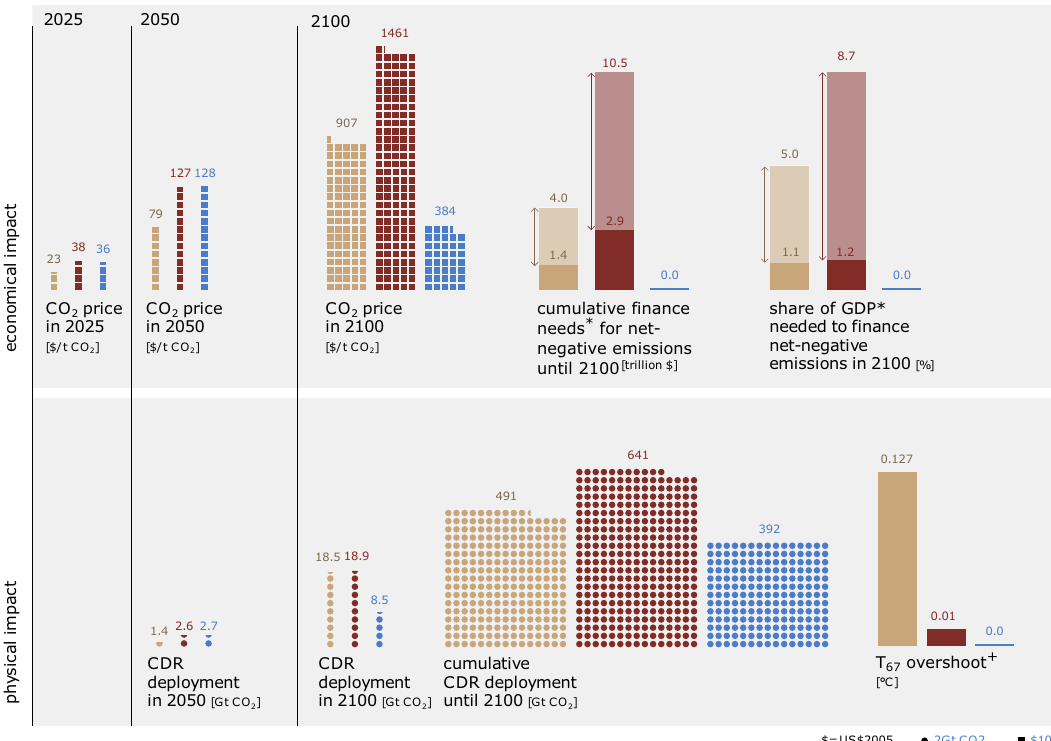
Fig. 2 Risk pro fi le of Hotelling Overshoot (light brown), Hotelling Below (dark brown), and Optimal (blue) scenarios. The upper panel shows the economic impact indicators CO 2 price (in 2025, 2050, and 2100), fi nance needs for net-negative emissions in absolute values and as share of GDP. The lower panel shows physical impact indicators Carbon Dioxide Removal (CDR) deployment (in 2050 and 2100), cumulative CDR deployment, and temperature overshoot. The Optimal scenario reduces long-term economic and physical risks and has near- and medium-term risks comparable to the Hotelling Below scenario. *These fi nance needs for net-negative emissions show upper estimates for the case that CDR is rewarded with the full current carbon price and lower estimates for the case that CDR is rewarded with no more than 250 $/tCO 2 , which would avoid high rents for CDR companies. + The temperature overshoot is calculated as the difference of the maximum mean temperature and the mean temperature in 2100 in a scenario where the carbon budget is met in 2100, which is ~1.7